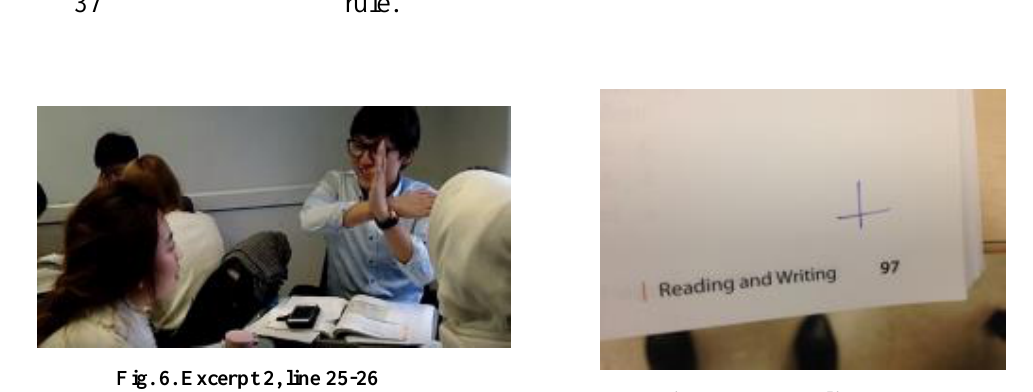
Fig. 7. Excerpt 2, line